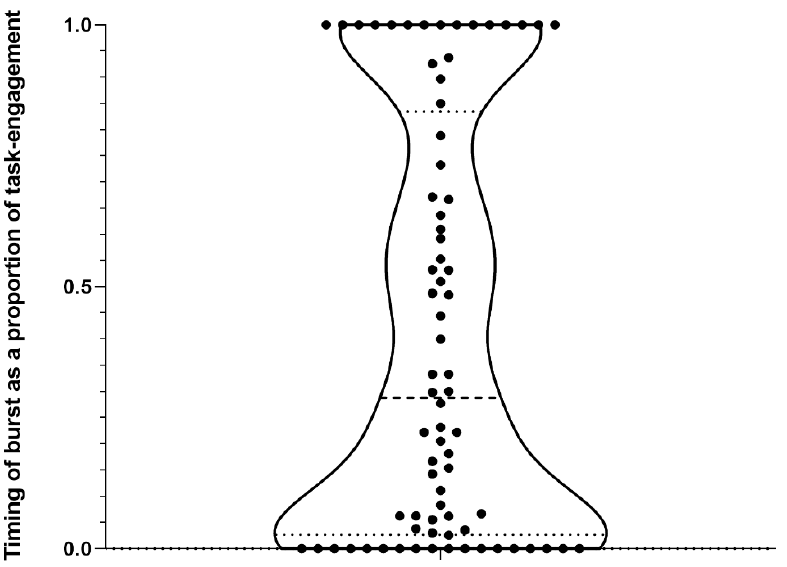
Figure 3. Timing of bursts ( n = 76 closed circles) within bouts of task-engagement. The timing of each burst is shown as a proportion of the duration of the bout it occurred within. Dashed line: median, dotted lines: quartiles.